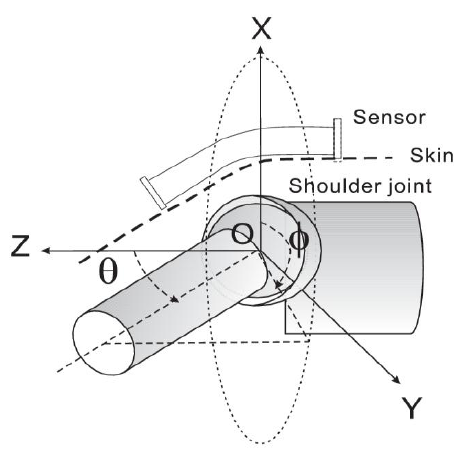
Figure 2. Skeleton of shoulder joint and definitions of